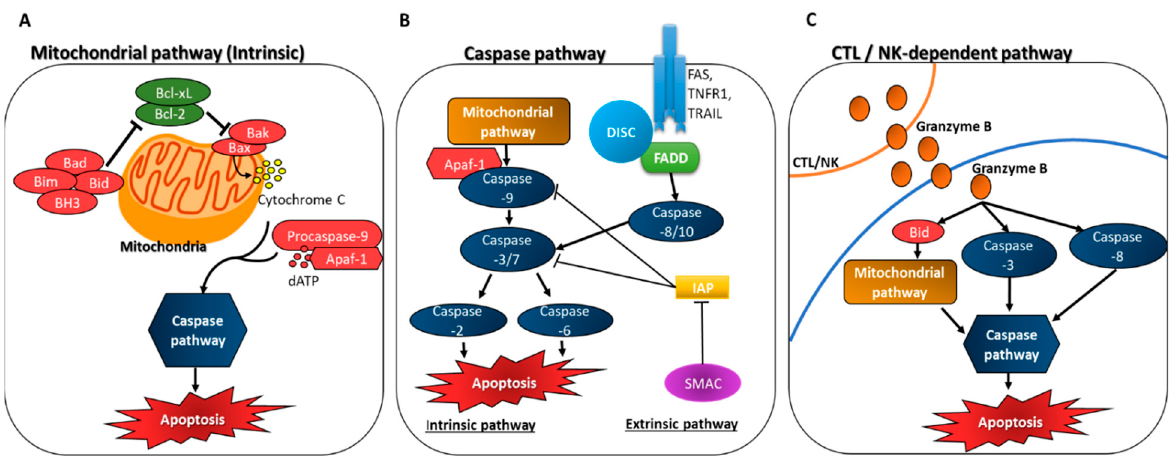
Figure 1. Three major pathways that induce stimuli that activate the caspase apoptosis pathway: ( A ) Mitochondrial pathway (intrinsic); ( B ) Caspase pathway; ( C ) CTL/NK dependent pathway. Bcl-extra-large (Bcl-xL); Bcl-2-associated X protein (Bax); Bcl-2-antagonist/killer (Bak); Bcl-2 associated agonist of cell death (Bad); Bcl-2 interacting mediator of cell death (Bim); Bcl-2 homology-3 (BH3); BH3-interacting domain death agonist (Bid); Apoptosis protease-activating factor-1 (Apaf-1); Deoxyadenosine triphosphate (dATP); Death-inducing signaling complex (DISC); FAS- associated death domain protein (FADD); TNF receptor 1 (TNFR1); TNF-related apoptosis-inducing ligand receptors (TRAIL); inhibitor of apoptosis protein (IAP); Second mitochondria-derived activator of caspases (SMAC); Cytotoxic T lymphocytes/natural killer cells (CTL/NK).